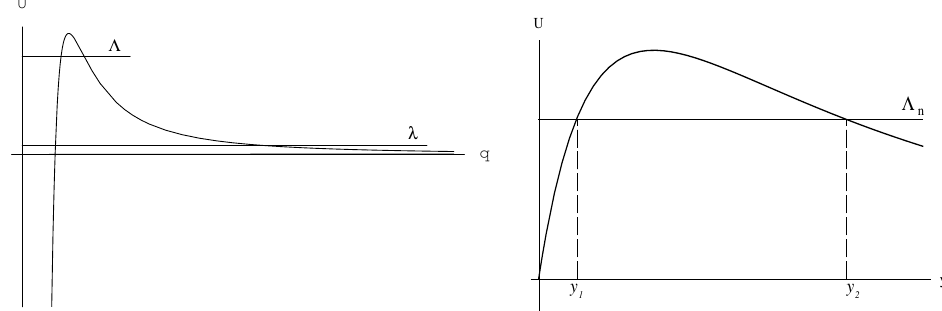
Figure 1. ( Left ): Typical behavior of a potential U ( q ) . Quantum levels are shown for the initial and the present vacuum states. ( Right ): Typical behavior of a potential U ( y )